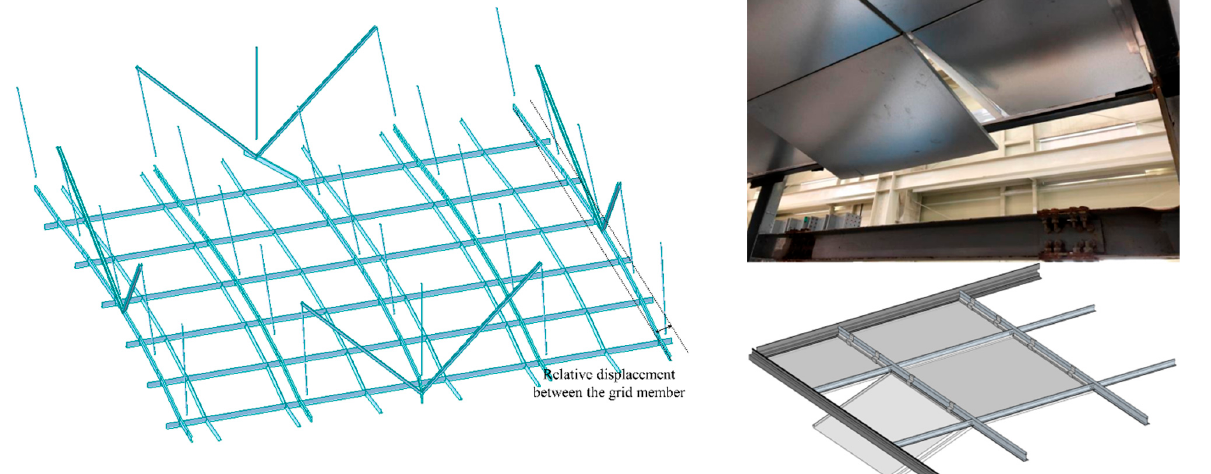
Figure 16. The cause of damage for the dislodged panel and hanging of the end panel of the ceiling system. 3. Dislodged panel and hanging of the middle panel. 2